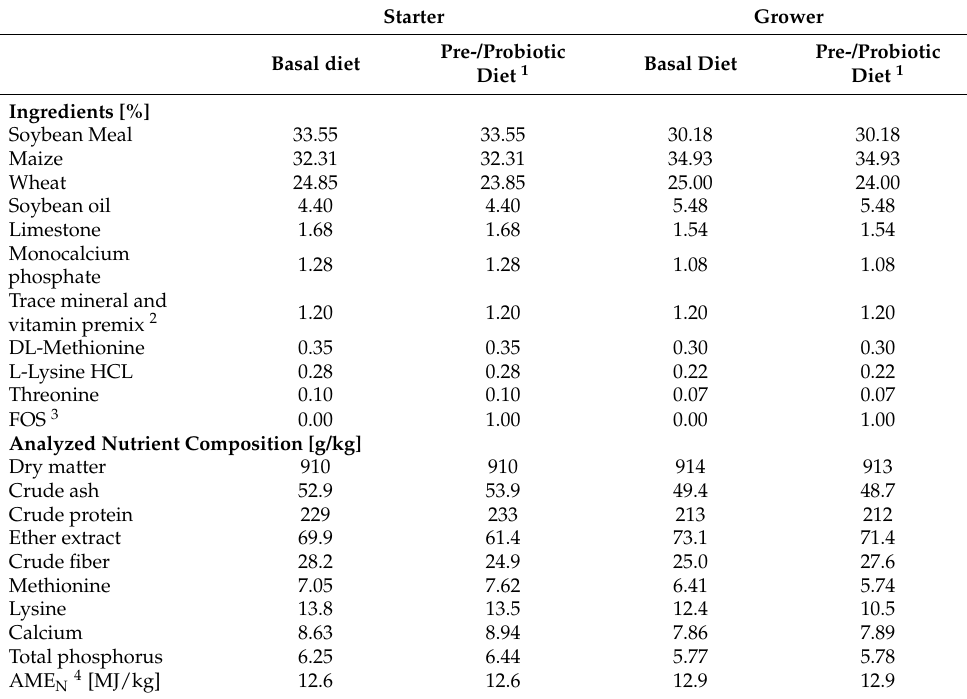
Table 6. Composition and analyzed nutrient composition of the experimental diets (as-fed basis). The experimental starter diet was fed on days 1–14 and the grower diet on days 15–28 to Ross 308 broiler